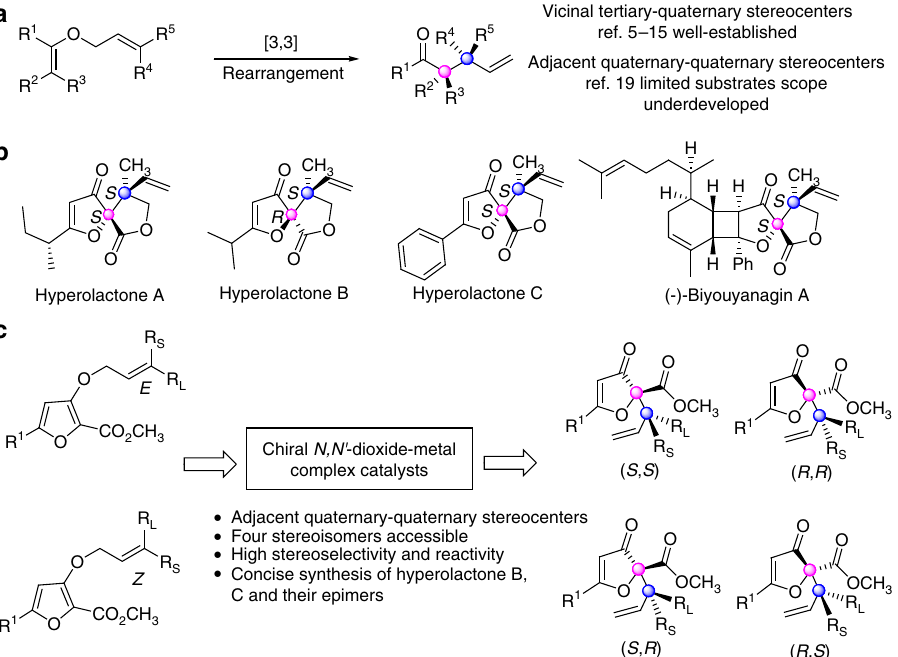
Fig. 1 Asymmetric Claisen rearrangement of allyl vinyl ethers and representative natural products containing adjacent quaternary stereocenters. a Previous work for the catalytic asymmetric Claisen rearrangement of allyl vinyl ethers. b The structures of natural products hyperolactones A – C and ( − )-biyouyanagin A. c Our catalytic asymmetric Claisen rearrangement strategy for stereodivergent construction of adjacent quaternary